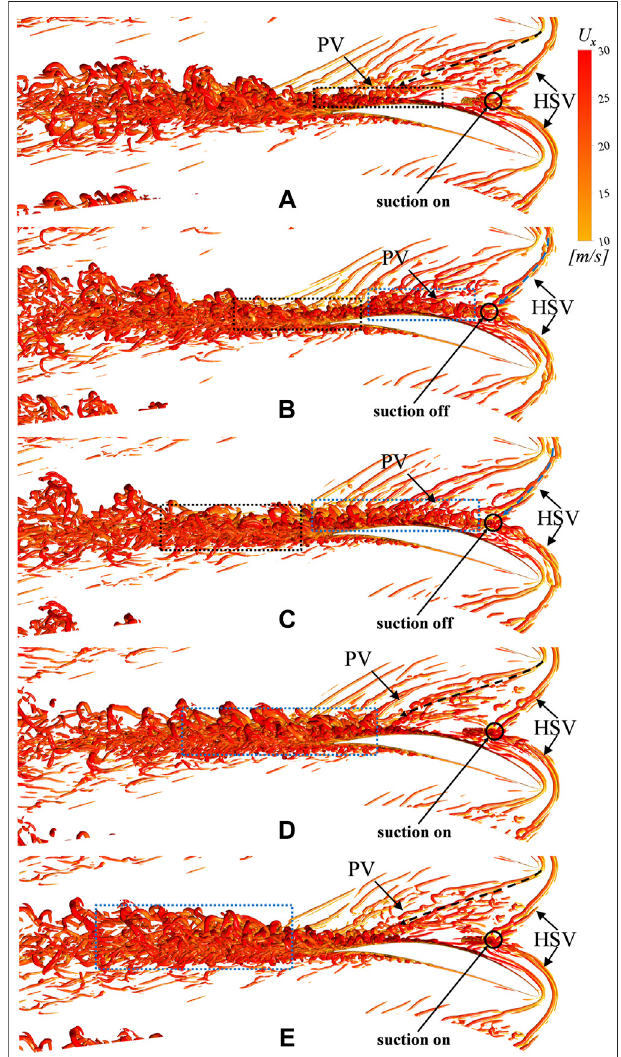
FIGURE 8 | Top – down view of the instantaneous vortex structures for the PS con fi guration ( Q = 5,000,000). (A) t = T; (B) t = T + 1/4 τ (C) t = T + 1/ 2 τ ; (D) t = T + 3/4 τ ; (E) t = T + τ